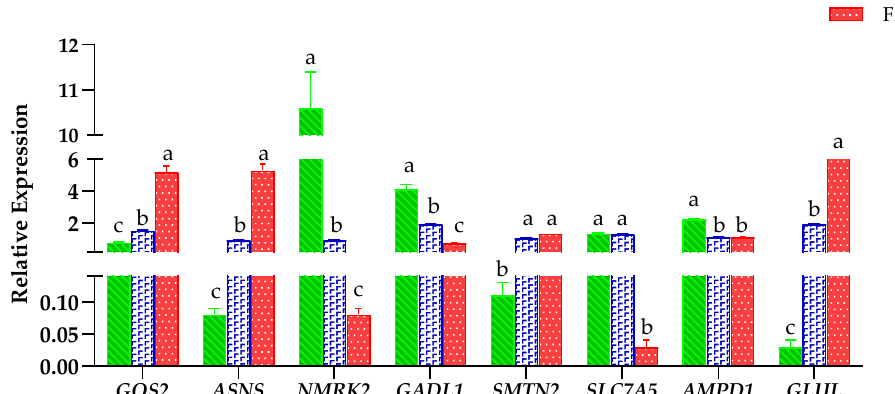
Figure 4. Validation of candidate DEGs under three rearing systems using real-time quantitative PCR. For each gene, different lowercase letters (a–c) indicate significant differences ( p <